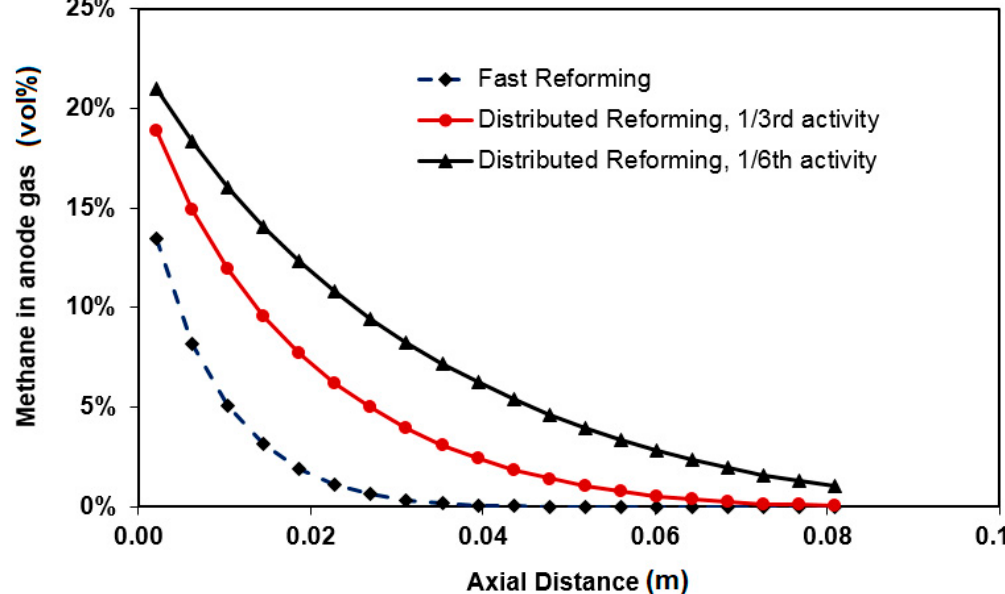
Figure 3. Methane concentration profiles for different reforming activity.